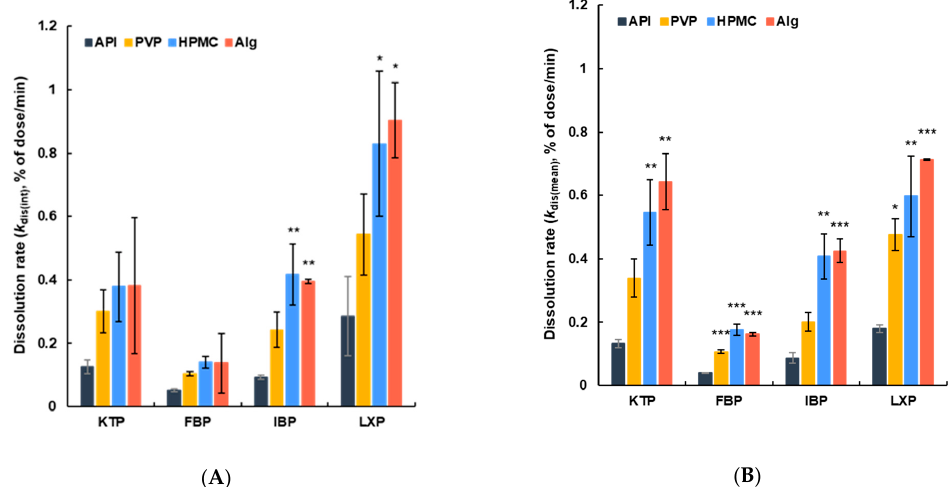
Figure 6. Dissolution rate constant of film formulations. ( A ) The initial dissolution rate from 1 to 5 min ( k dis(int) ) and ( B ) the mean dissolution rate from 5 to 120 min ( k dis(mean) ). Columns show data for the control solid formulation derived from API alone (black), film formulation of API with PVP (yellow), film formulation of API with HPMC (blue), and film formulation of API with Alg (orange). Data are expressed as the mean ± SEM ( n = 3–5). Statistical significance is denoted with ***, p < 0.001; **, p < 0.01; *, p < 0.05 compared to respective control formulations.